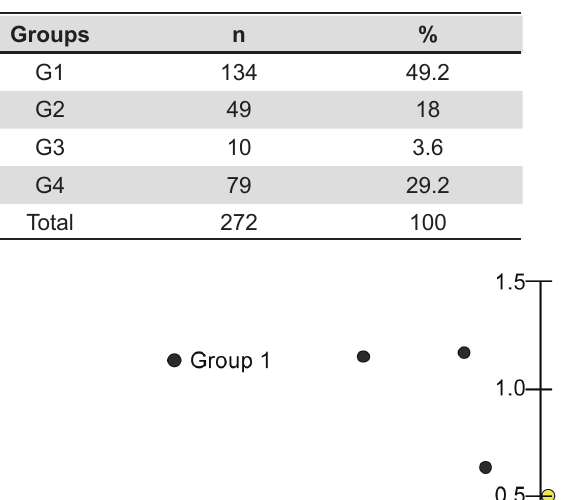
Table 3- Distribution of the children in each of the four NDT groups